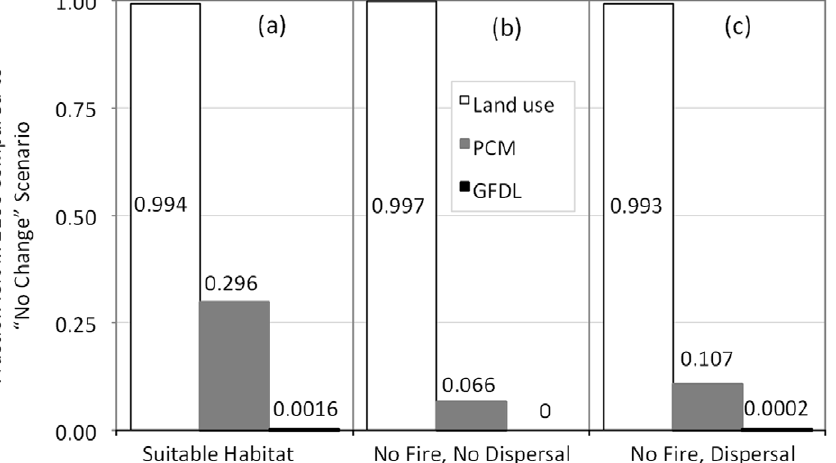
Figure 2. Q.engelmannii habitat ratios and population ratios under various assumptions. (a) Suitable habitat areas predicted for 2100 as ratios to suitable habitat areas estimated for 2000. The ratios are based only on habitat suitability maps. (b) The demographic component of the model is added, but with no fire and no dispersal. Each bar represents a ratio of a 2100 predicted population under a land use or climate change scenario to the 2100 predicted population under the no change scenario (where, in the no change scenario, suitable habitat is the same in 2000 and 2100). (c) Dispersal is added as described in text eqn 5, with the high values of average dispersal distance d =10 km, and maximum dispersal distance D max =20 km, and with the flow parameter a =0.01. All calculations for this figure assume the absence of fire.